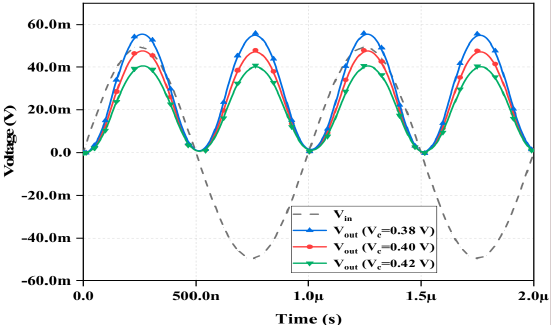
Figure 7. Transient response at frequency f = 1 MHz and V P = 50 mV considering Variable V C .